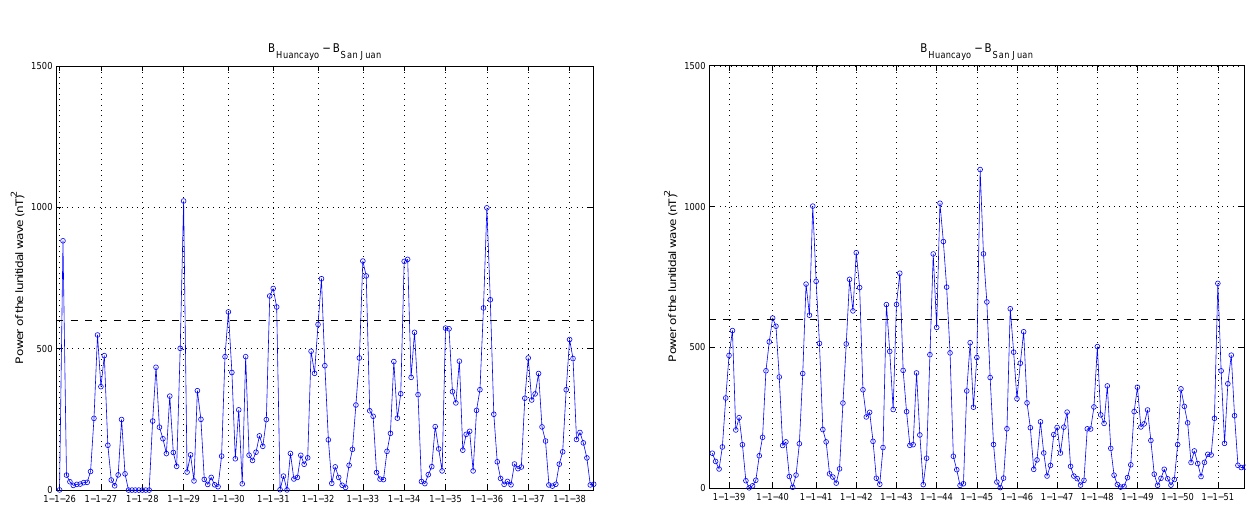
Figure 6. As Fig. 5, but for the period 1939–1951. Table 2. Gaussian curve